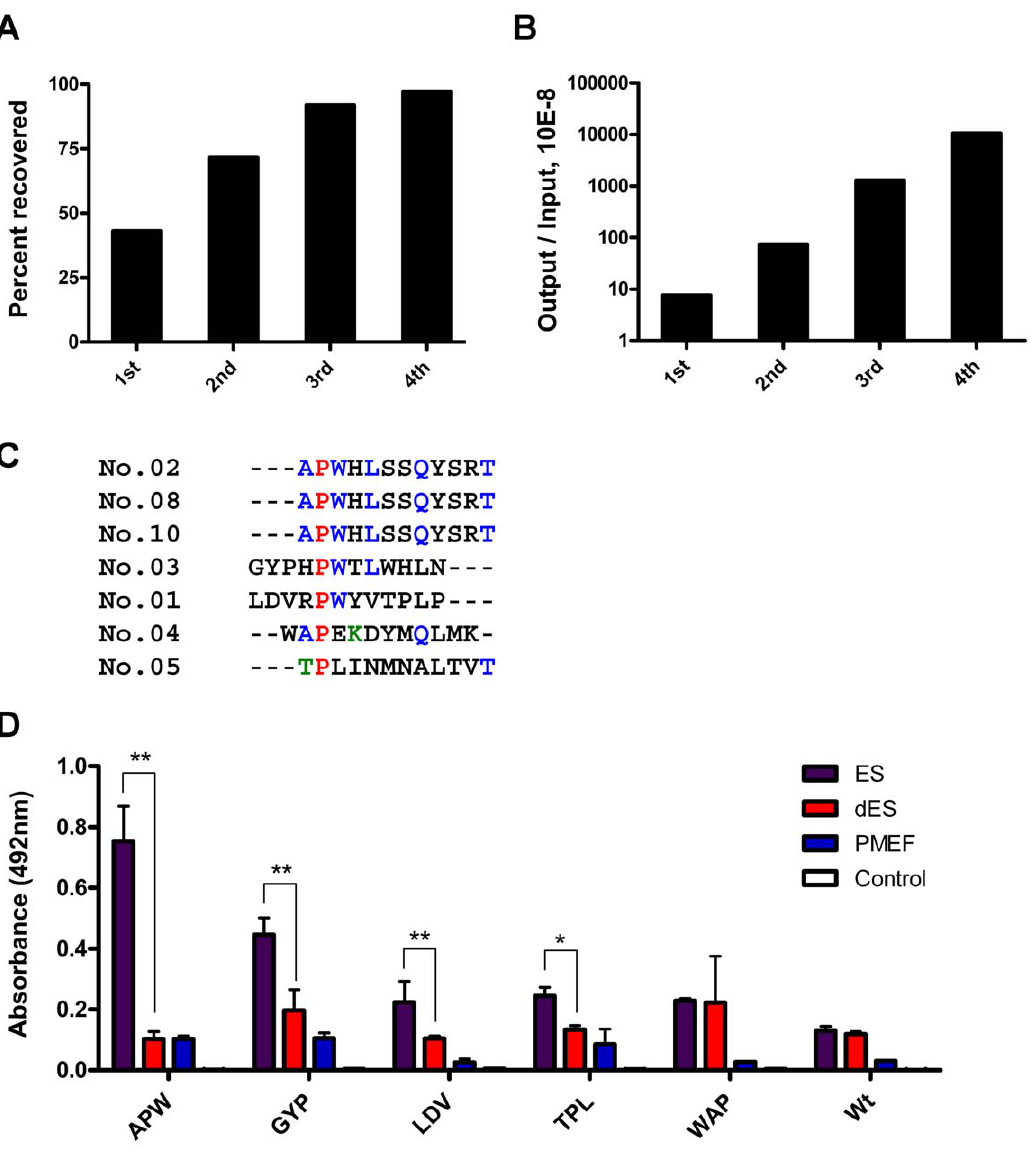
Figure2. SelectionofPh.D-12 phagepools against ES cells. (A)Subtraction efficiency with dES cellsandPMEFs. Thephagepool underwentthree subtractions with dES cells and three subtractions with PMEFs in each round of biopanning. The efficiency is shown as the percentage of recovered phage numbers from subtraction to input phage numbers. (B) Selection efficiency with ES cells. The binding efficiency of phage pool is shown as the percentage of eluted phage numbers to input phage numbers in each round of biopanning. (C) Alignment of peptide sequences displayed by monoclonal M13 phages selected binding to ES cells. Identical sequences are shown in color. (D) Affinity and specificity of purified candidate M13 phages binding to indicated cell types using ELISA. The peptides displayed by selected phages are APWHLSSQYSRT, GYPHPWTLWHLN, LDVRPWYVTPLP, TPLINMNALTVT, and WAPEKDYMQLMK. The first three amino acid letters of these sequences are used to stand for the correspondingphages. Results are presented as absorption value (mean 6 standard derivation) in ELISA assay. Each experiment was repeated three times independently. **: p , 0.01, and *: p , 0.05 using ANOVA test. BSA and M13 wild type phage (Wt) were used as the negative controls.